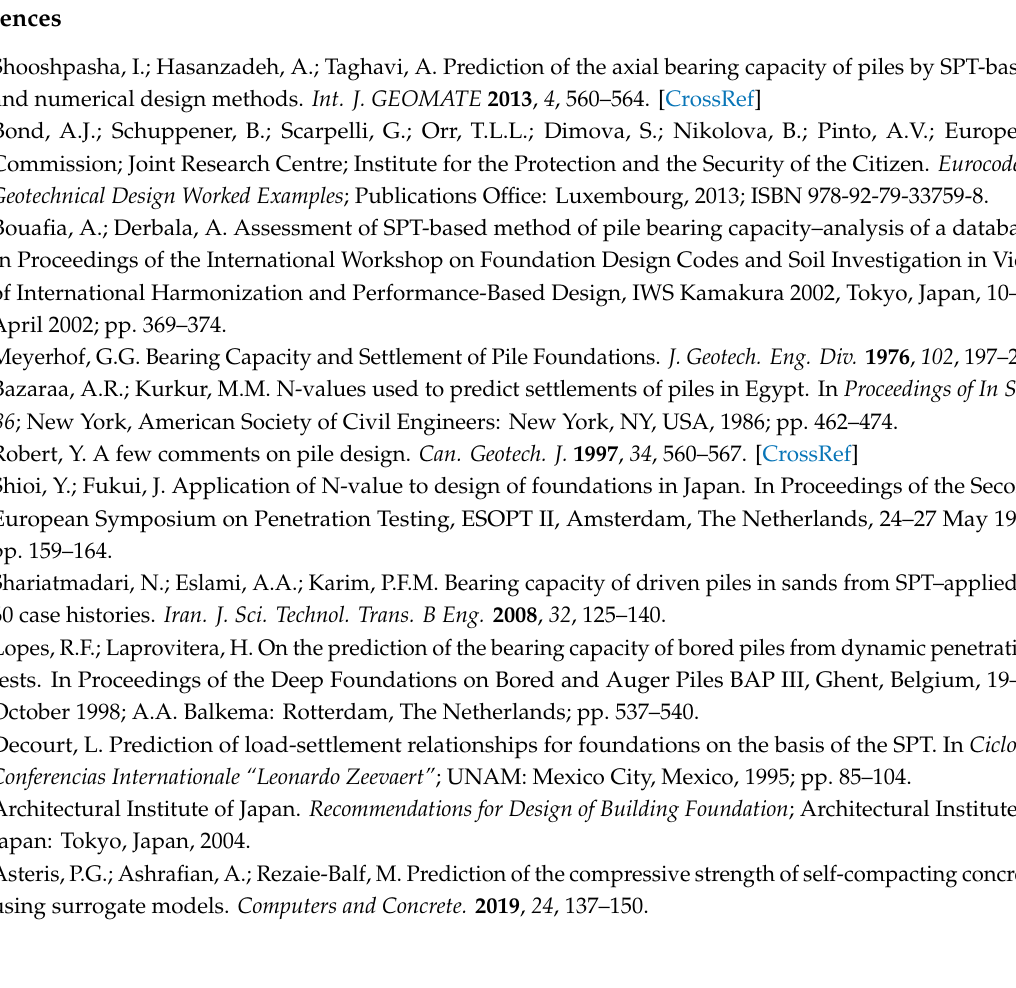
Figure A3. Log–log load–settlement relationship for pile number P_140.